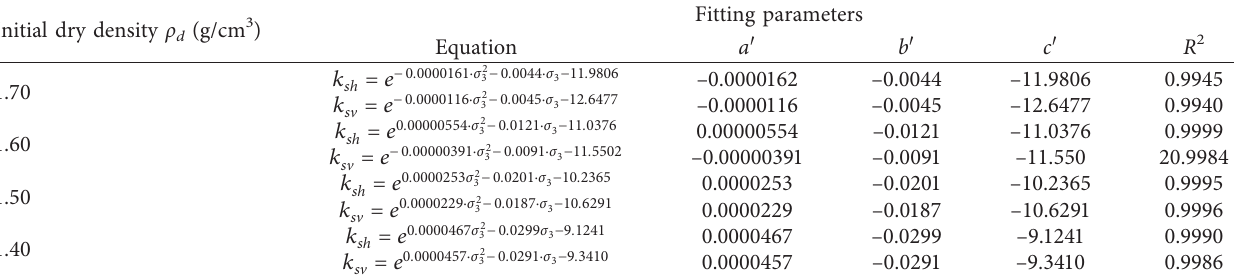
Table 4: Fitting parameters of the saturated permeability coefficient and consolidation confining pressure. Initial dry density ρ d (g/cm 3